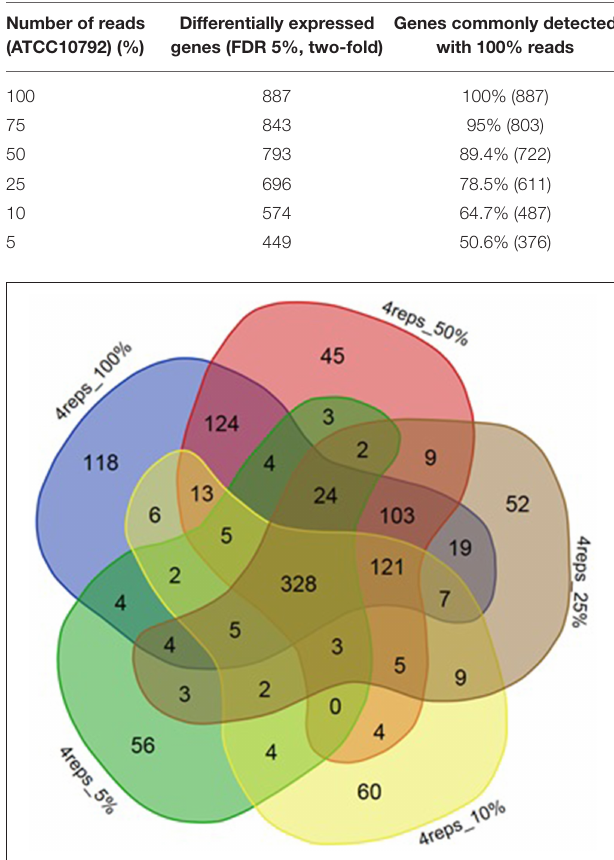
FIGURE 5 | Venn diagram depicting effect of reducing number of reads on DE gene numbers. The effect of decreasing of read numbers on significantly differentially expressed genes and the number of genes commonly detected within sets of 100, 50, 25, 10, 5% reads for strain